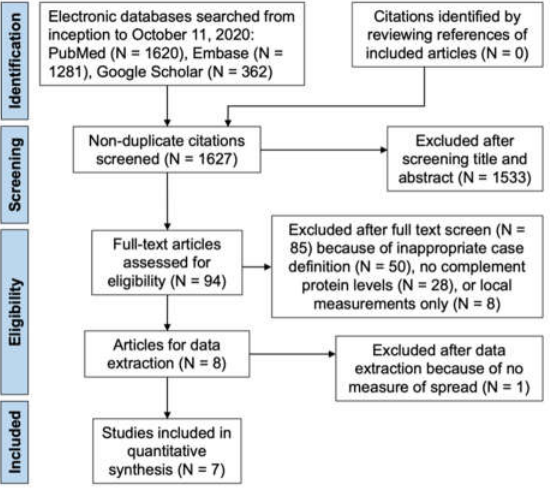
Figure 1. Preferred Reporting Items for Systematic Reviews and Meta-Analyses (PRISMA) Flow Diagram showing citations identified, included, and excluded with reasons for exclusions. Adapted with permission from ref. [9] with modifications. 2022, American Academy of Ophthalmology. Table 1. Characteristics of the Studies Included in the